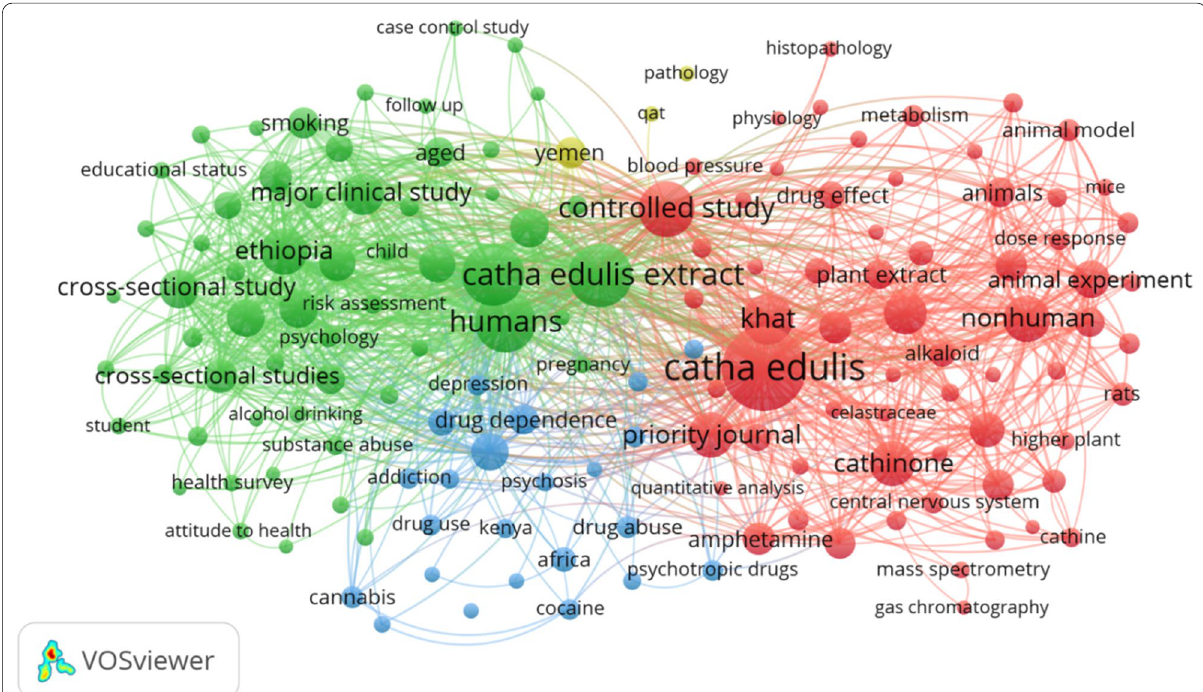
Fig. 12 Network visualization map of terms in the titles/abstracts with a minimum occurrence of twenty or more. Color-coordinated nodes are tightly coupled and form a distinct cluster. Each cluster reflects a broad study subject found in the materials retrieved